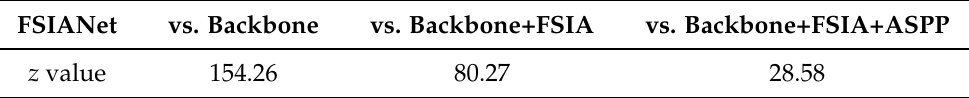
Table 5. McNemar’s test of the ablation study over the proposed FSIANet on the East Asia Dataset.